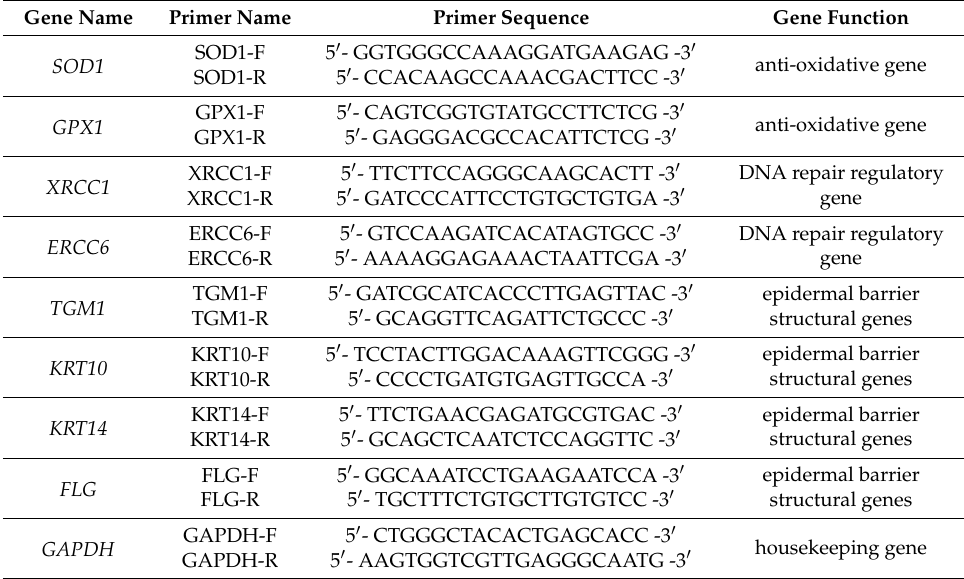
Table 1. Real-time quantitative PCR primers used in this